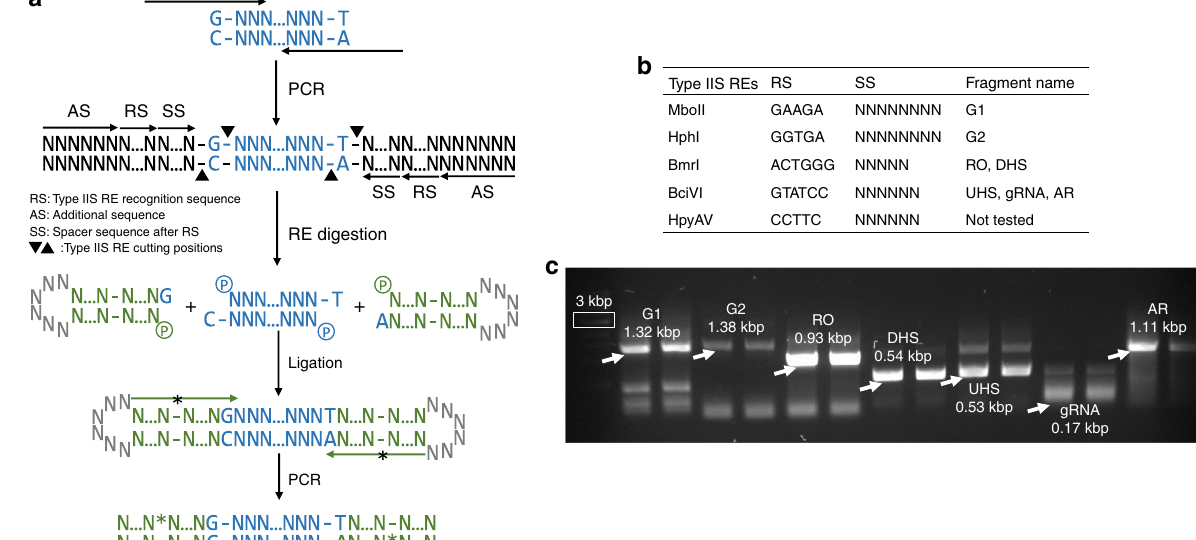
Fig. 4 Development of Type IIS RE-based barcoding method. a Principal of using Type IIS RE to generate fragment with 1-nt SEs. The non-modi fi ed Foligos (shown as long black arrow) include additional sequence (AS, six random nucleotides), recognition sequence (RS), spacer sequence (SS, the length of SS depends on Type IIS RE used) and primer binding site. The ampli fi ed fragments were enzymatically digested by using the corresponding REs, and ligated with two Boligos. The ligation mixtures were used as templates in ligation PCR to amplify barcoded fragments by using corresponding PS-modi fi ed Aoligos (shown as long green arrow with *). b Five Type IIS REs can be used to generated 1-nt SEs. We have tested four of them to barcode seven fragments. The RS and SS of the fi ve Type IIS REs are provided. G1: gene 1; G2: gene 2; RO: replication origin (pMB1); DHS: downstream homologous sequence; UHS: upstream homologous sequence; gRNA: guide RNA; AR: antibiotic resistance marker (Spec R ). c Analysis of the products of ligation PCR. The desired bands are indicated by white arrows. Five barcode fragments (RO, DHS, UHS, gRNA, and AR) could be assembled into plasmid nupG -pTarget (Fig. 2c). DNA marker with 3 kbp size is highlighted in white rectangular box. The other two barcoded fragments (G1 and G2) were cloned into a pre-prepared plasmid backbone to construct two plasmids (Supplementary Fig. 7a). The transformation ef fi ciencies and assembly accuracies of these three plasmids can